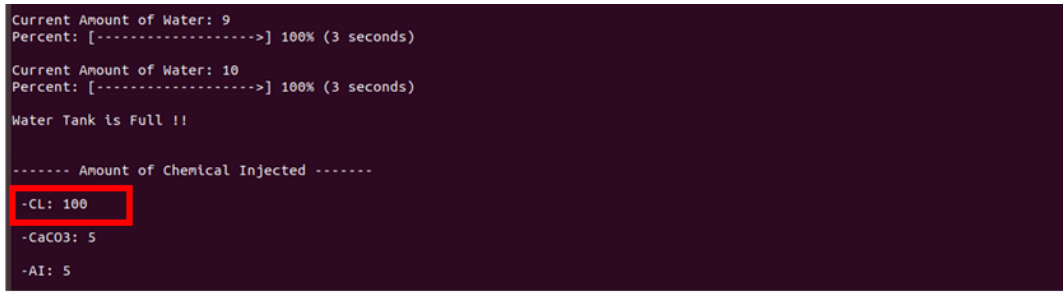
Figure 16. Attacker check open ports. 2.